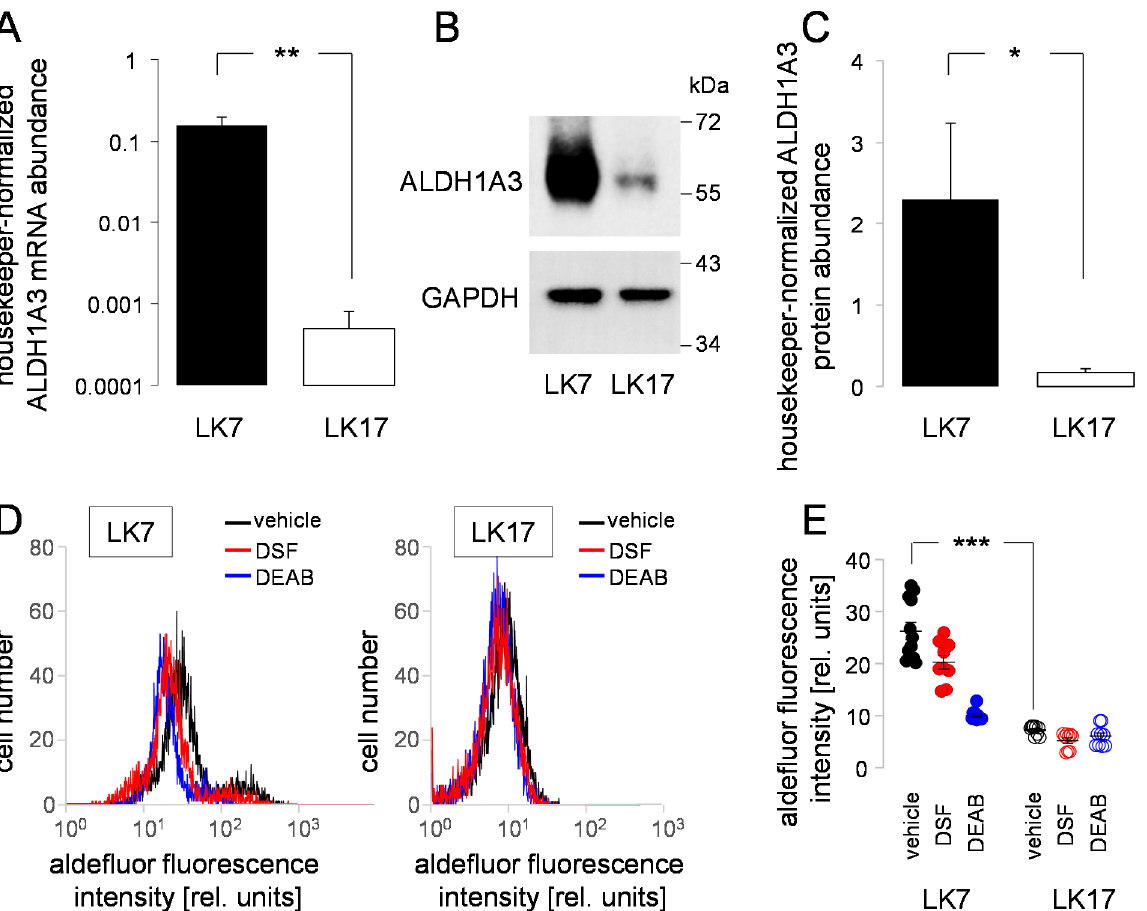
Figure 3. Primary glioblastoma stem-cell cultures LK7 and LK17 differ in ALDH1A3 mRNA and protein abundance and in ALDH activity. ( A ) Mean ( ± SE, n = 7–9) housekeeper-normalized ALDH1A3 mRNA abundance of LK7 (left) and LK17 cells (right) as quantified by real-time RT-PCR. ( B ) Representative immunoblots of total lysates from LK7 (left) and LK17 (right) cells probed against ALDH1A3 (top) and—for loading control—GAPDH (bottom). ( C ) Mean ( ± SE, n = 9–10) housekeeper-normalized ALDH1A3 protein abundance of LK7 (left) and LK17 cells (right) determined as in ( B ) by immunoblotting. ( D ) Representative histograms recorded by flow cytometry showing the aldefluor-specific fluorescence intensity of LK7 (left) and LK17 (right) cells after incubation in the absence (vehicle, black) and presence of the ALDH inhibitor diethylaminobenzaldehyde (DEAB, 3 µM, blue) or disulfiram (DSF, 100 nM, red). ( E ) Individual and mean (±SE, n = 9–12) aldefluor fluorescence intensities (geometrical means) measured as in (D) by flow cytometry in LK7 (left) and LK17 (right) cells after incubation with vehicle (black), disulfiram (red), or DEAB (blue). * and ** in ( A , C ) and *** in ( E ) indicate p ≤ 0.05, 0.01, and 0.001, respectively, as calculated by Welch-corrected two-tailed t -test ( A , C ) and nonparametric Kruskal–Wallis and Dunn’s multiple comparisons test ( E ).